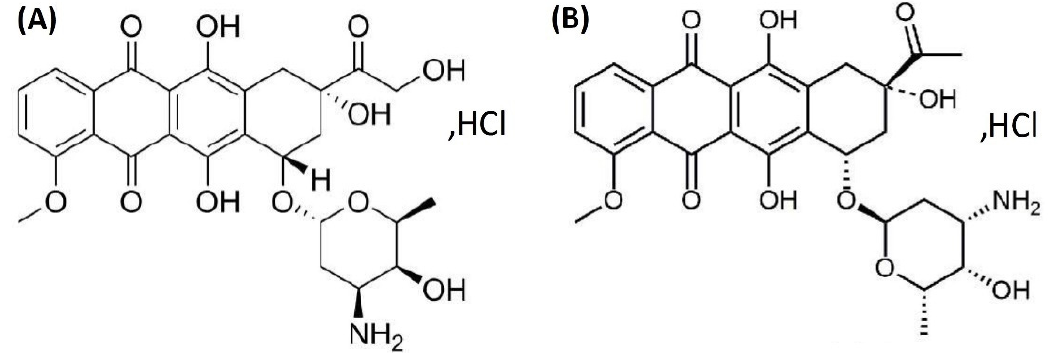
Figure 1. Chemical structure of doxorubicin (DOX) ( A ) and daunorubicin (DAY) in the form of hydrochloric acid salts ( B ).